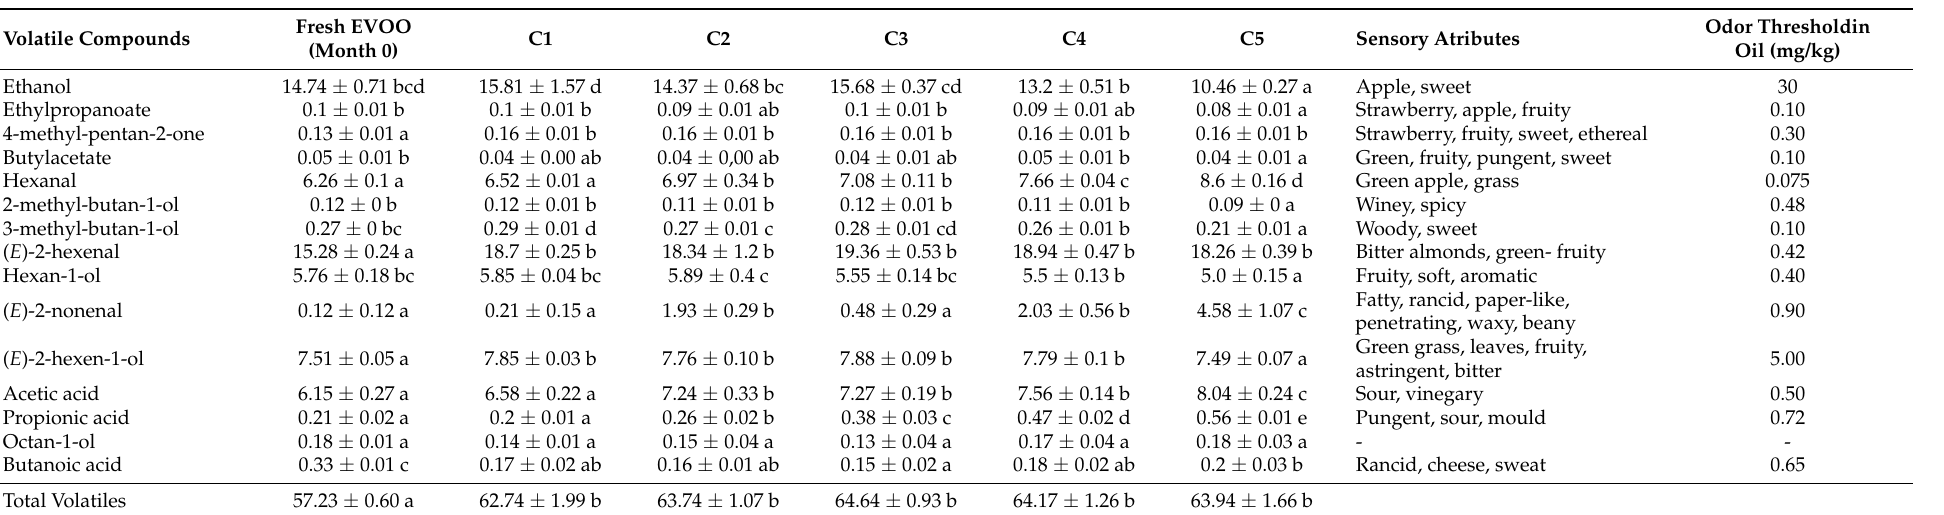
Table 3. Content of volatile compounds after 12 months of storage under different